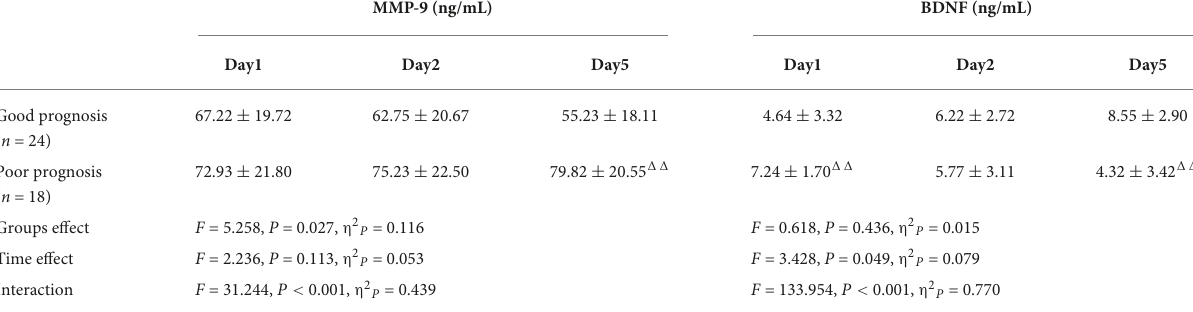
TABLE 2 Difference among Day1, Day2,and Day5 time points for serum MMP-9 and BNDF levels for AIS patients in the good and poor prognosis groups.